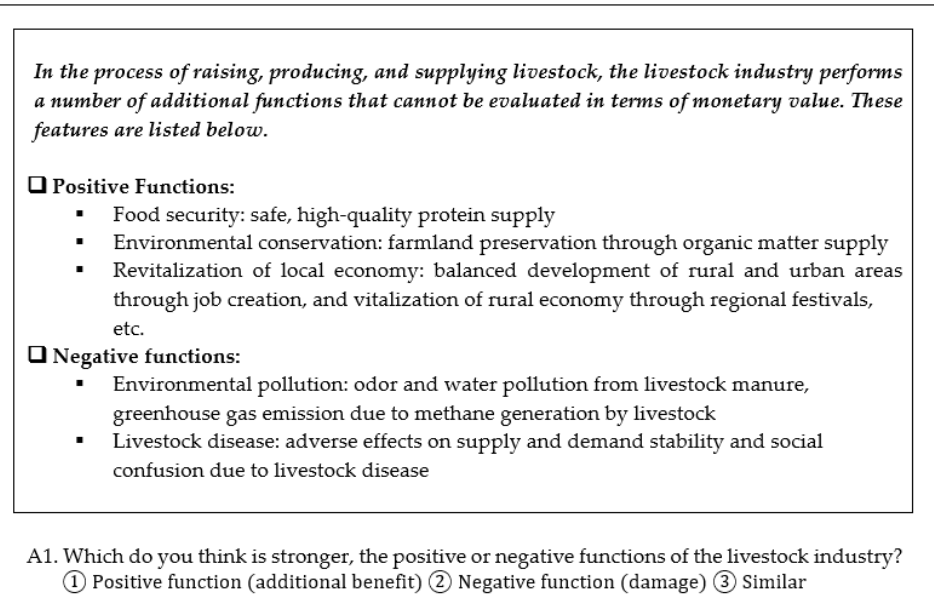
Figure 1. Sample question for a respondent’ s opinion on the aspects of the livestock